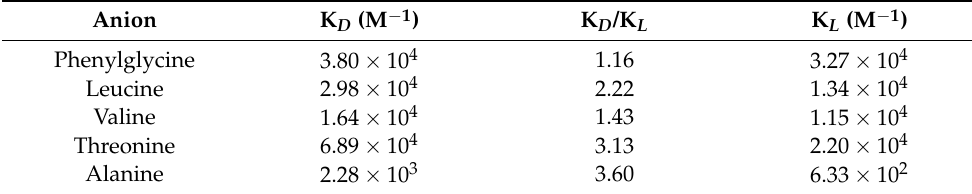
Figure 17. Chromophore receptor 57. Table 2. Association constants of complexes for 57 with TBA salts of Boc-protected amino acids in acetonitrile (1:1 binding model).